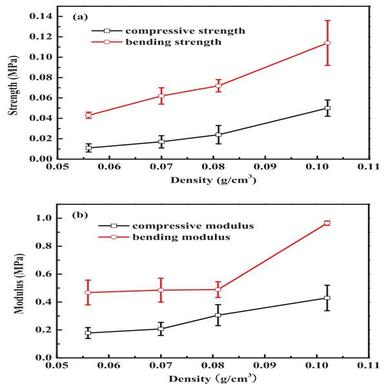
The relationships between mechanical parameters and densities of PFMs.